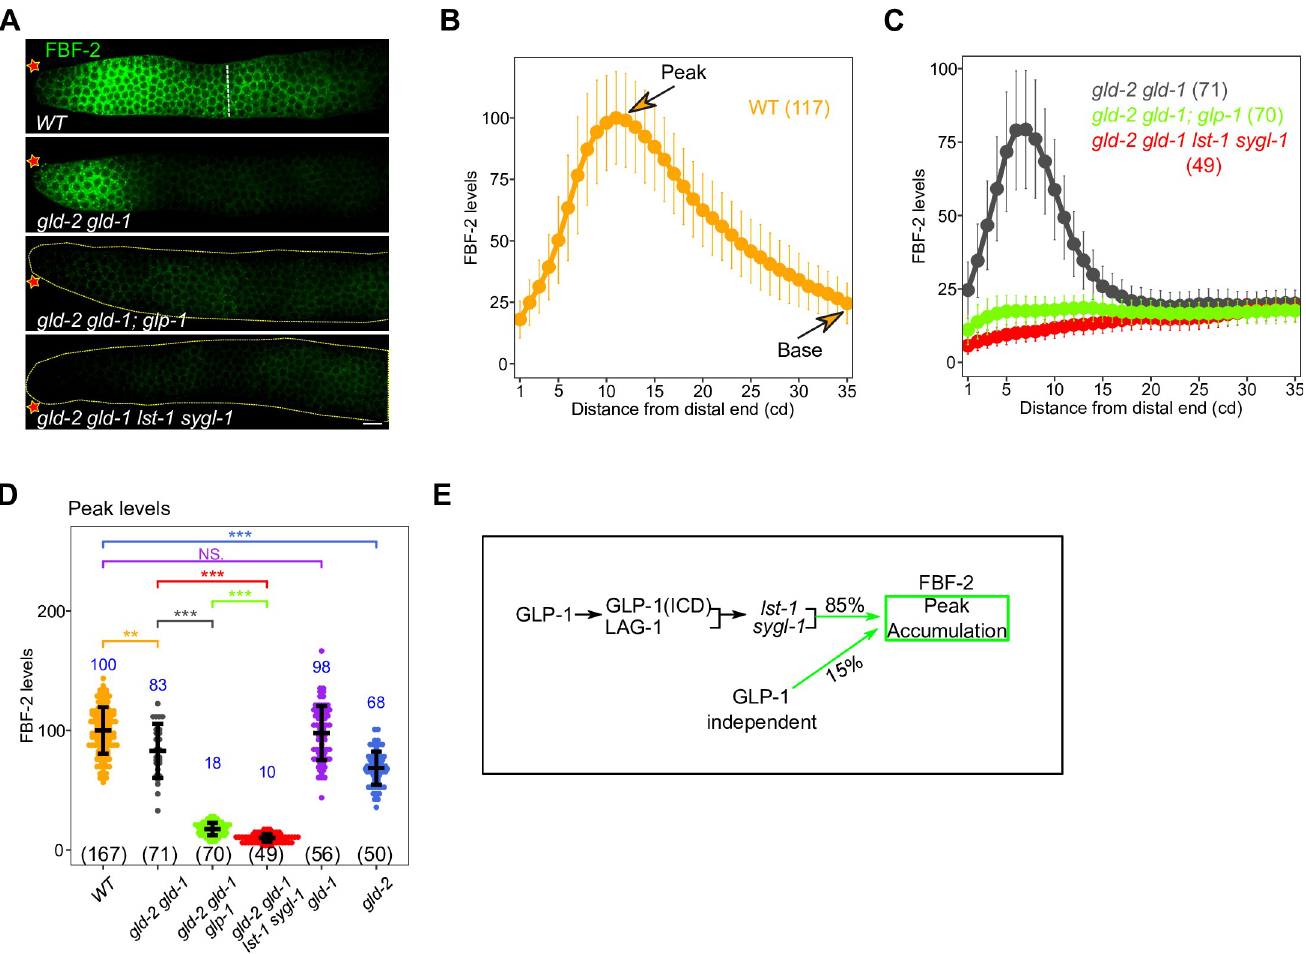
Fig 6. FBF-2 accumulation is post-transcriptionally controlled by GLP-1 transcriptional targets LST-1 and SYGL-1. (A) Images of V5-stained (FBF-2, green, from fbf-2(q932[3xV5 :: fbf-2]) germlines from dissected young adult hermaphrodites of the indicated genotype. See S1 Table for the complete genotypes. Star, distal end; dashed white line, meiotic entry. Scale bar is 10 μ m. (B—D) Plot of FBF-2 levels (B—C) and comparison of peak FBF-2 accumulation (D) for indicated genotype. Numbers indicate mean values of FBF-2 level for each genotype (in blue) and numbers in bracket shows the sample size. Dots, mean (B-C) or data points (D); Error bars, mean ± SD. P-value � 0.01 ( � ); � 0.001 ( �� ); � 0.0001 ( ��� ); > 0.01 non-significant (NS.). (E) Model depicting genetic control of FBF-2 peak levels and percent contribution to peak FBF-2 accumulation. Total of 85% of FBF-2 peak level can be attributed to GLP-1 signaling through GLP-1 transcriptional targets lst-1 and sygl-1